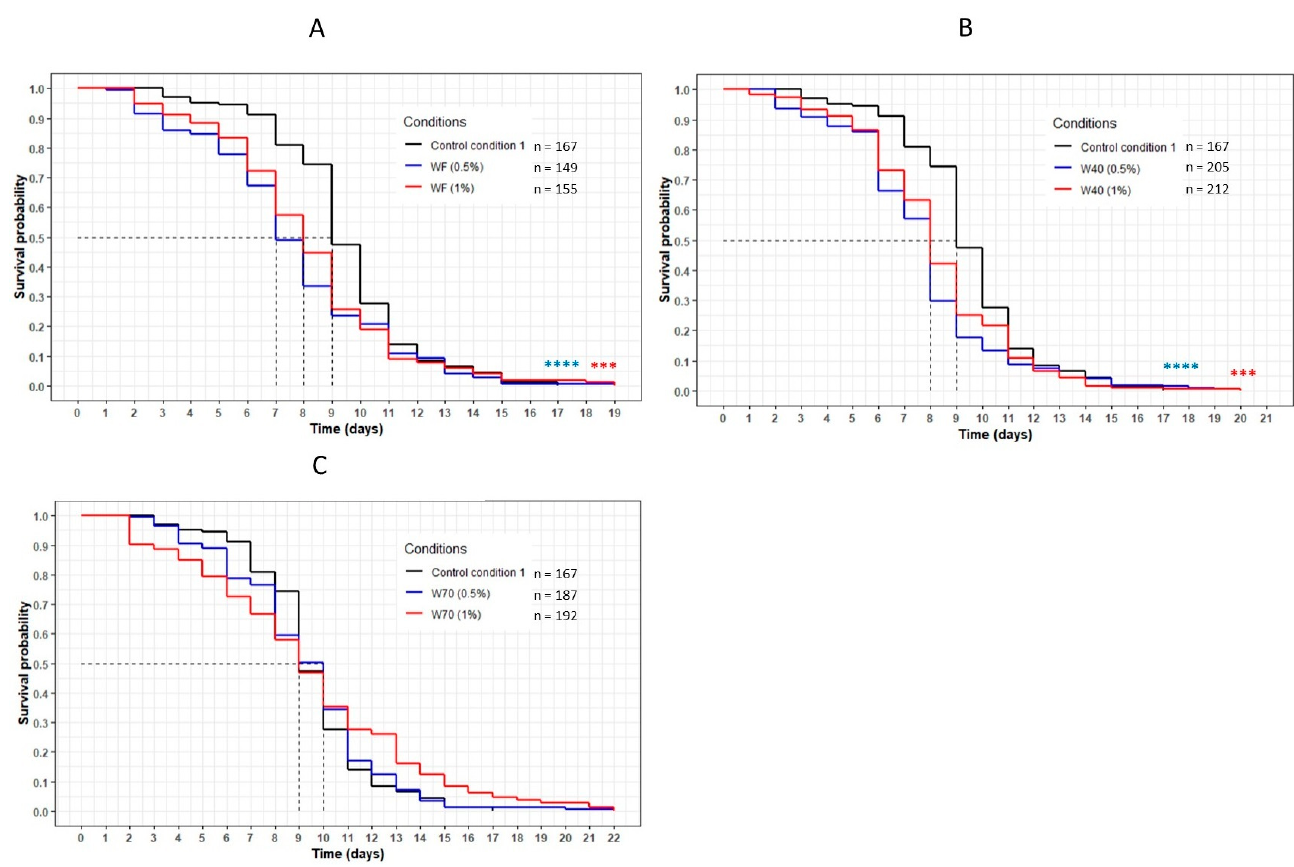
Figure 3. The influence of the aqueous extracts WF ( A ), W40 ( B ) and W70 ( C ) on the C. elegans GR1307 strain lifespan. The worms were incubated on the medium supplemented with the dried extracts at day 0 and regularly fed with HK E. coli OP50. The conditions were considered significantly different when the p -value was lower than 0.001 (***) or 0.0001 (****) (log-rank test). The asterisks next to the curves represent the differences with the control condition CC1. The asterisks next to the legend represent the differences between the extracts.